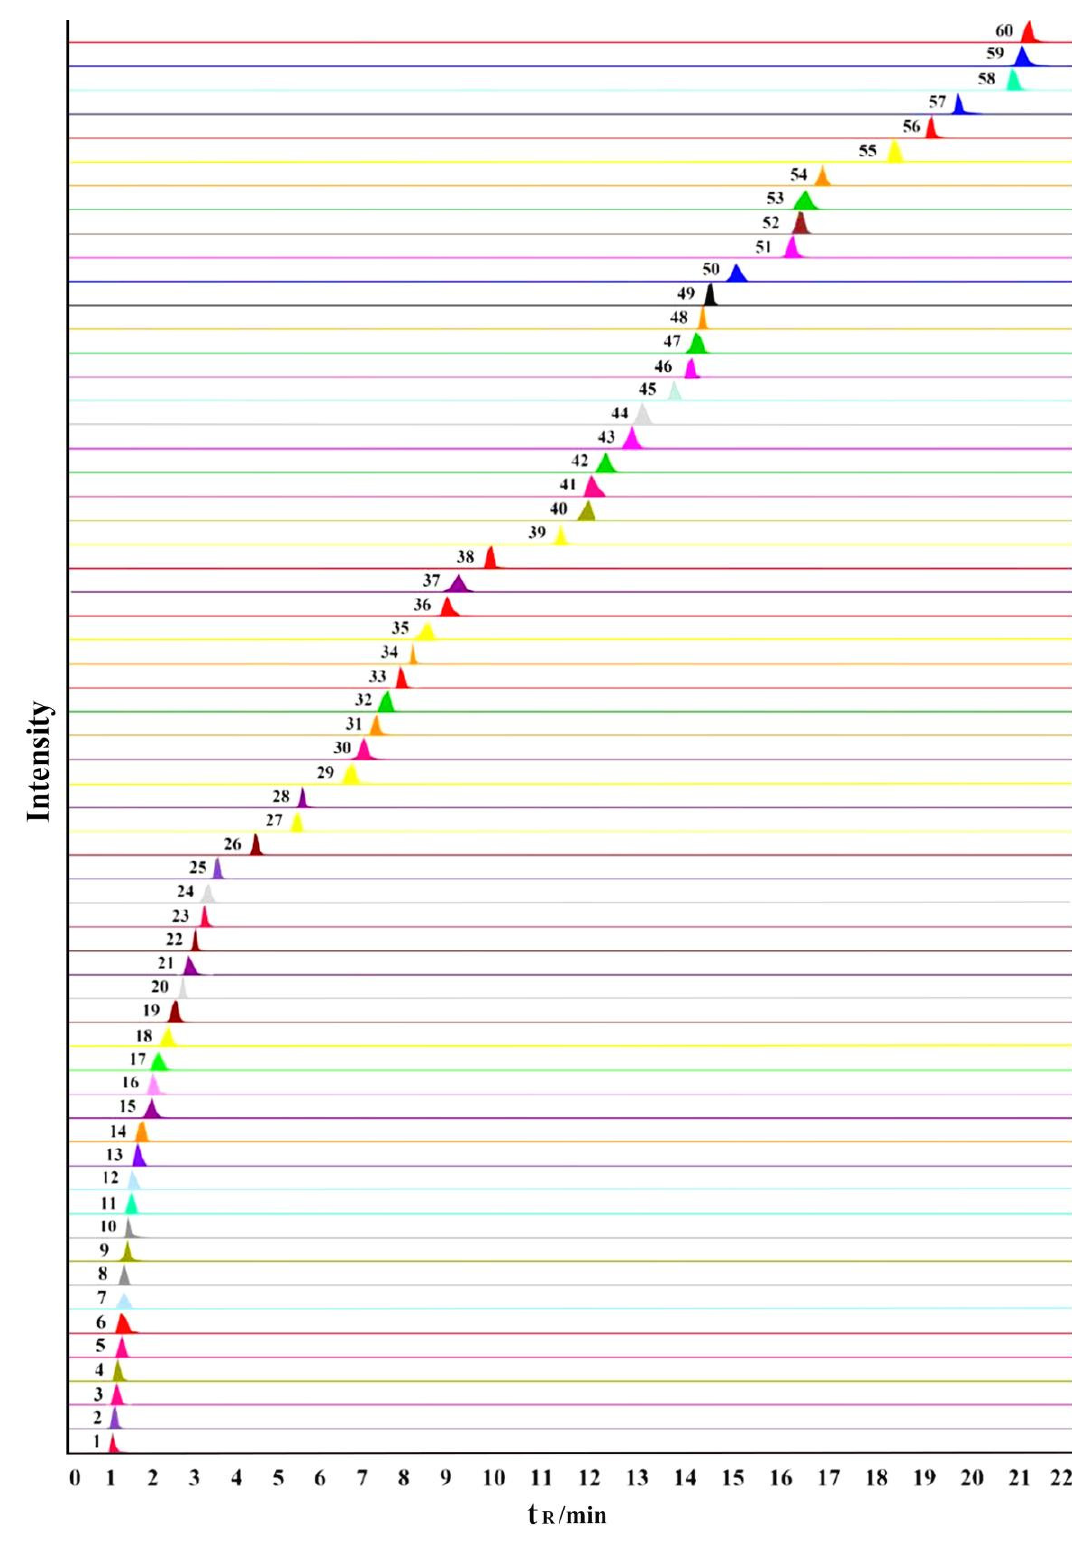
Figure 1. Representative extract ion chromatograms (XIC) of multiple-reaction monitoring (MRM) chromatograms of the 60 investigated constituents. (The peak numbers denoted are the same as those in Table 1.). Table 1. Optimized mass spectrometric parameters for MRM of 60 constituents.